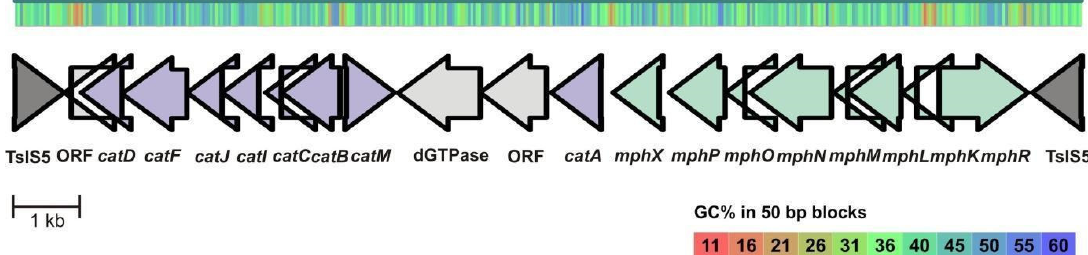
Figure 4. Genetic organization of the catechol degradation operon ( cat ) and phenol degradation operon ( mph ) of the Acinetobacter venetianus ICP1 (GenBank accession number MK140631). The genes